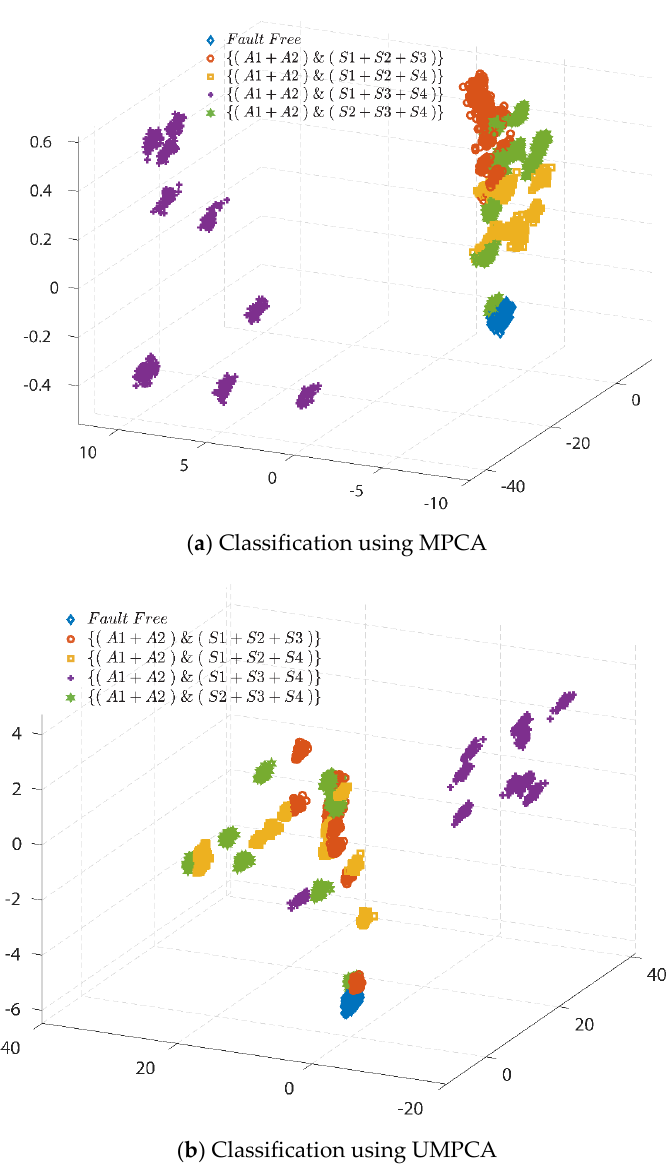
Figure 16. Three-dimensional space visualization performance for fault classification for wind turbines subjected to two actuator and three sensor faults under AWGN noises, by using ( a ) MPCA and ( b ) UMPCA, respectively.